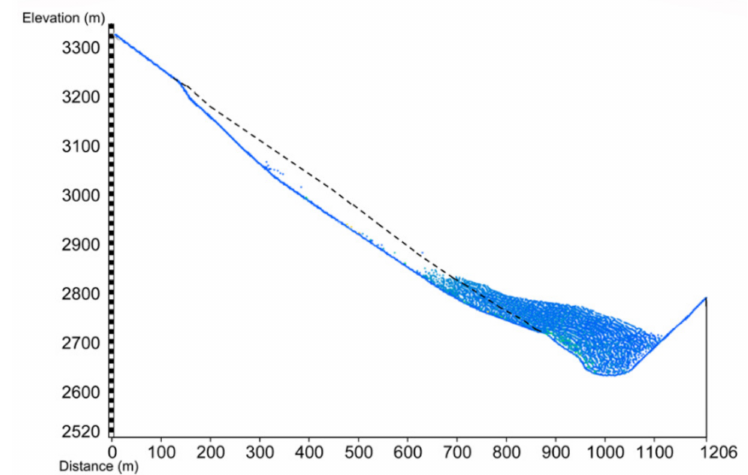
Figure 14. Post-landslide morphology of the accumulation